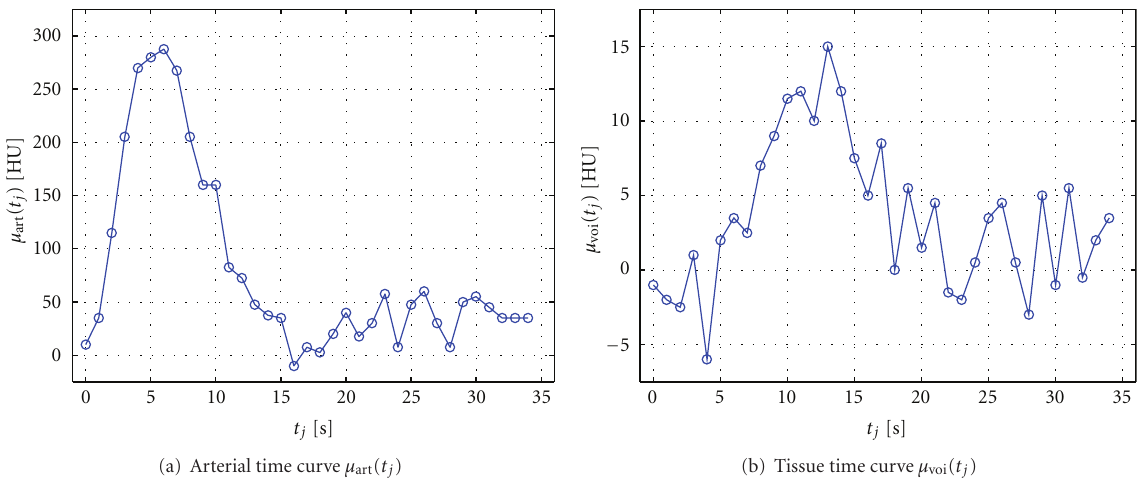
Figure 6: Examples of measured time-attenuation curves in perfusion CT in (a) an arterial vessel and (b) in tissue. The time curves have been pre-processed by baseline subtraction and removal of the baseline time frames. The example data is measured at N = 35 discrete time points.